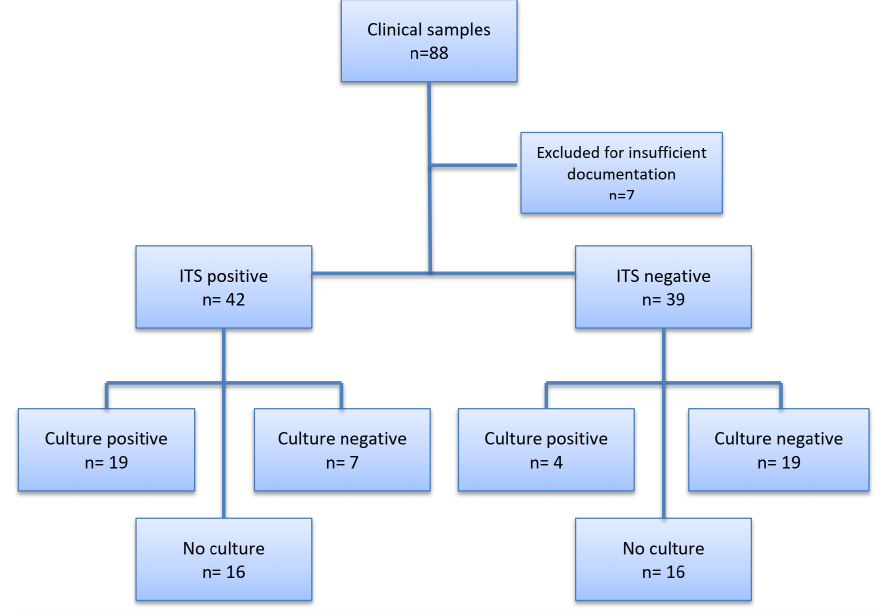
Figure 1. Flowchart of ITS-sequencing and conventional cultures. n = numbers